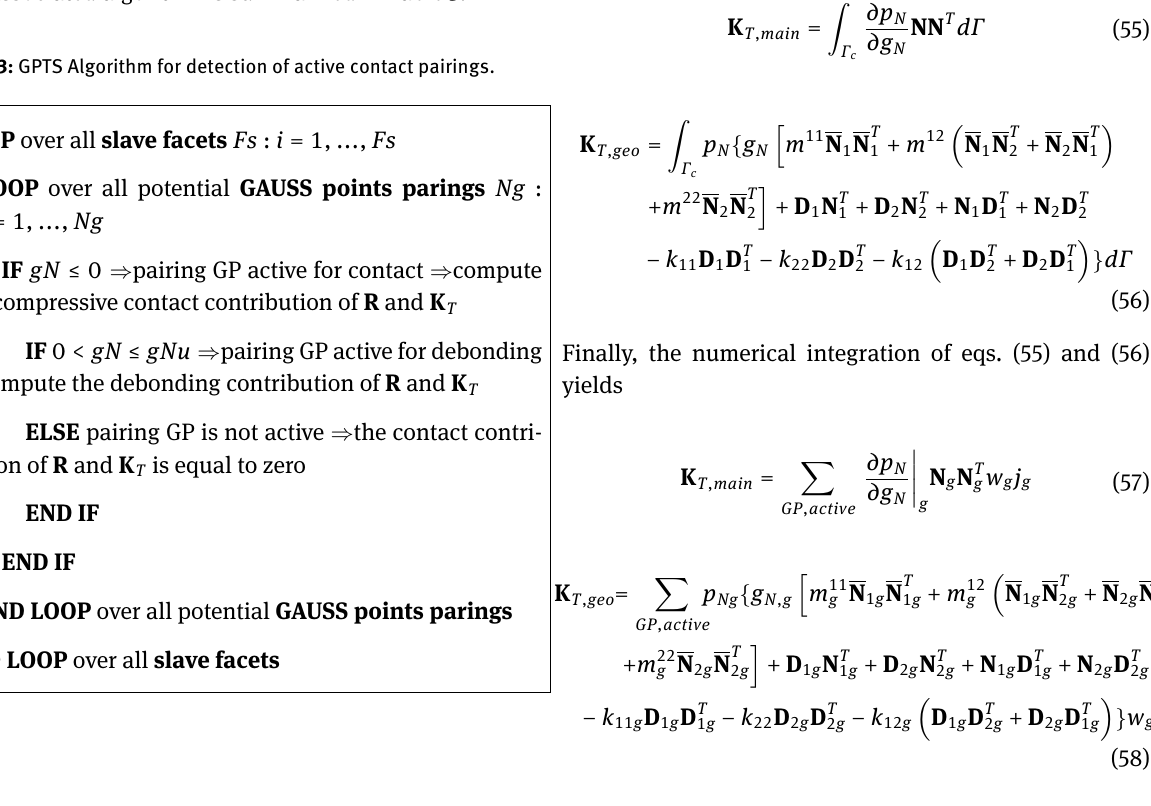
Table 3: GPTS Algorithm for detection of active contact pairings.